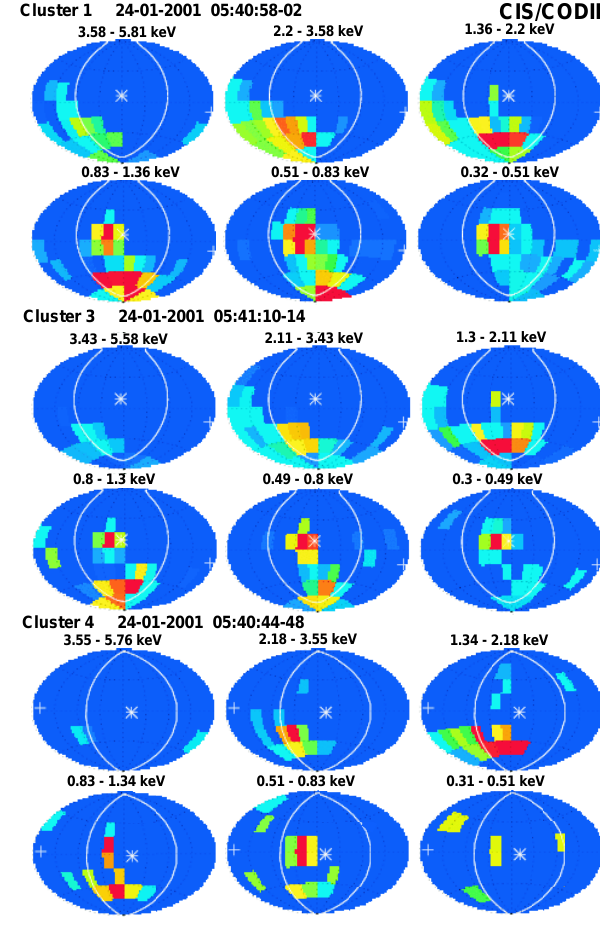
Fig. 3c. Similar representation as Fig. 3b, 3 spacecraft spin periods later into the shock